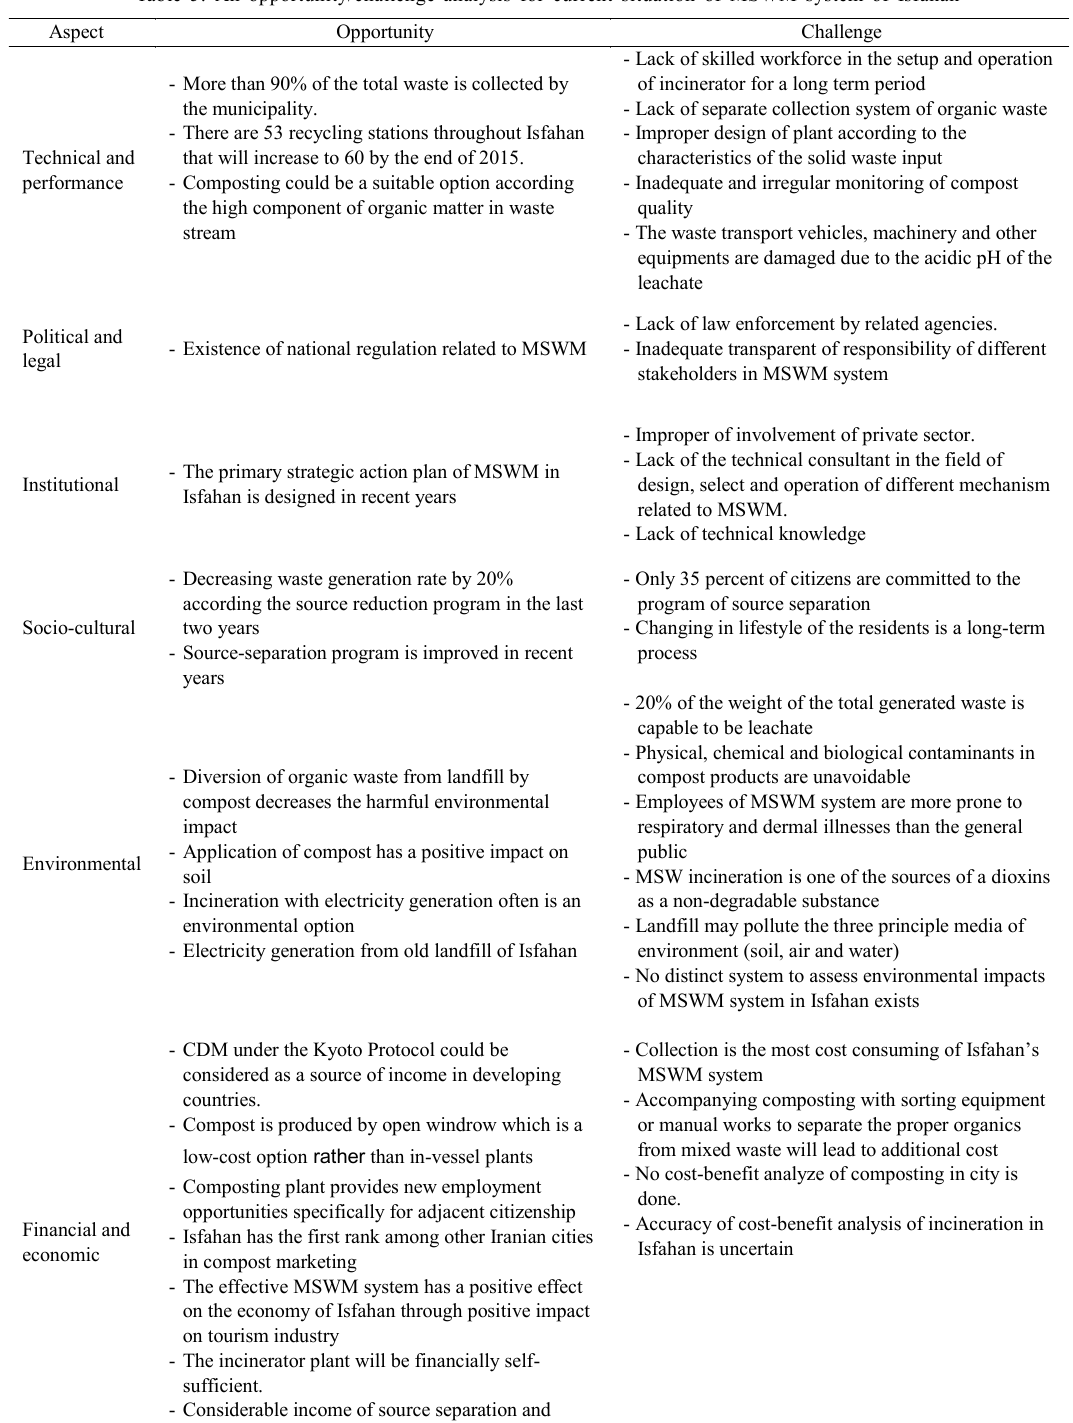
Table 5: An opportunity/challenge analysis for current situation of MSWM system of Isfahan Aspect Opportunity Challenge